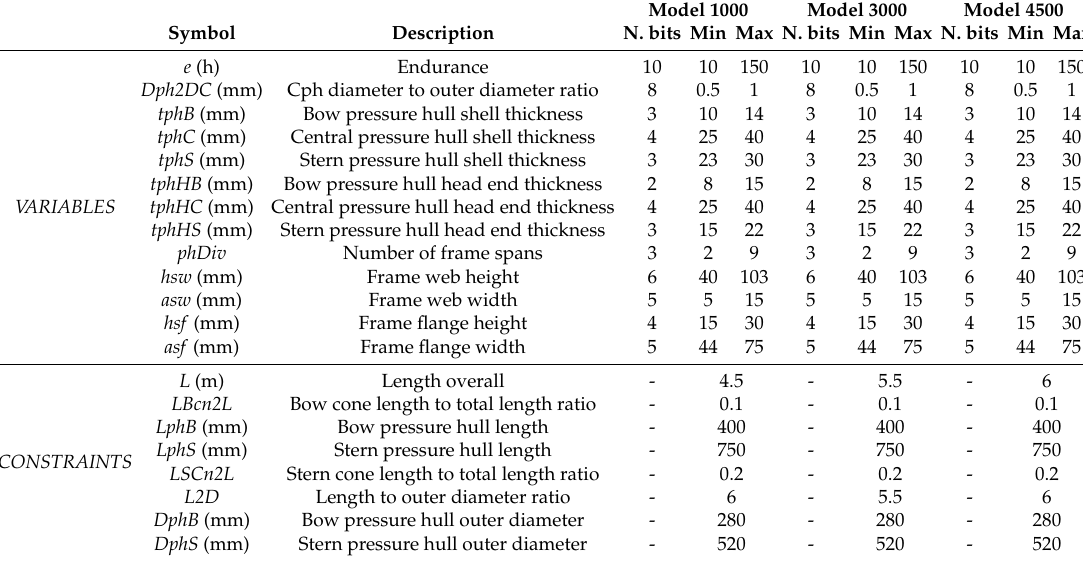
Table 2. DMFC-AUV\QpDM variables and constraints. Upper section: definition of the number of bits for each variable and their variation range. Lower section: definition of the values of each constraint. Cph, central pressure